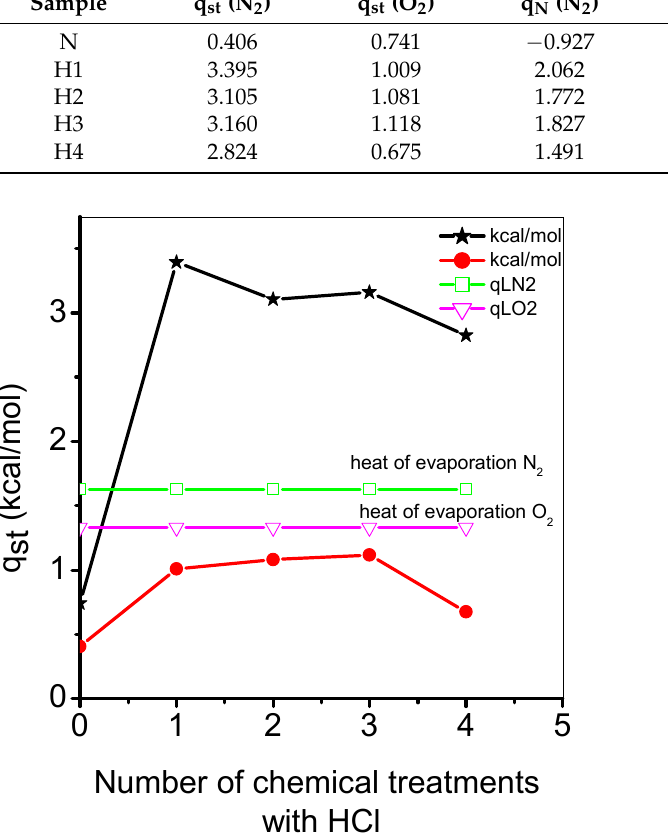
Figure 7. Isosteric enthalpies of adsorption (qst, Kcal/mol) for N 2 and O 2 in clinoptilolite zeolites.